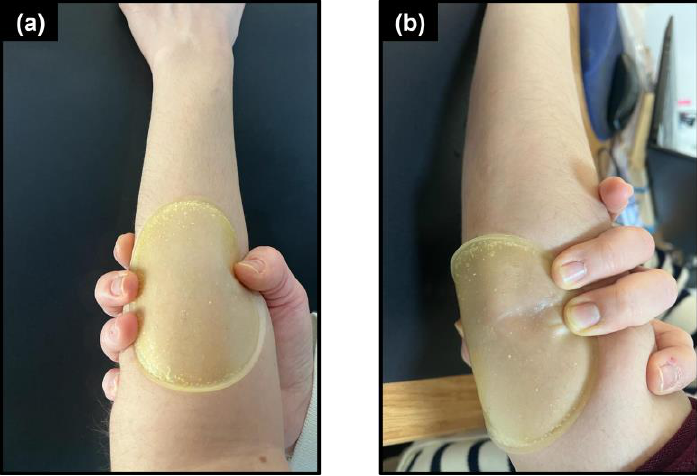
Figure 9. Adhesion of PIP film on ( a ) forearm and ( b ) elbow.